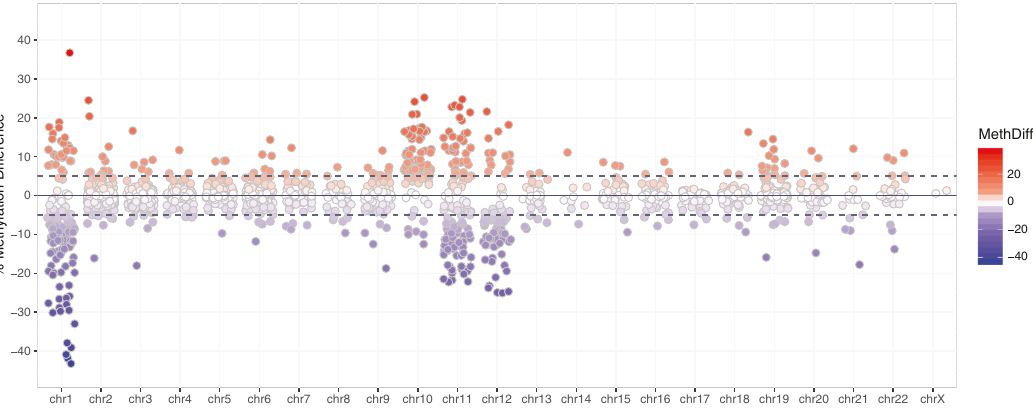
Fig. 1 Overview of differentially methylated CpG sites (DMC) in peripheral whole blood of neonates exposed to ACS treatment. Scatterplot of individual CpG sites that were signi fi cantly differentially methylated in ACS-exposed subjects as compared to unexposed controls. Each dot represents a DMC, visualized across the genome (FDR < 0.05). Chromosomes are displayed in numerical order along the x-axis. DMCs above and below the dashed line ( ≥ 5% methylation difference, 505 sites) were included in the analysis. Red dots above the dashed line represent hypermethylated DMCS that demonstrated greater than 5% methylation difference (231 DMC (46%)). Blue dots under the dashed line represent hypomethylated DMCs that demonstrated greater than 5% methylation difference (274 DMC